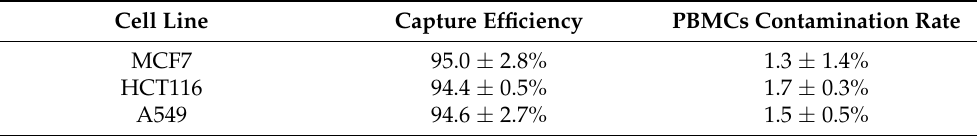
Table 1. The representative results for three cancer cell lines. Cell Line